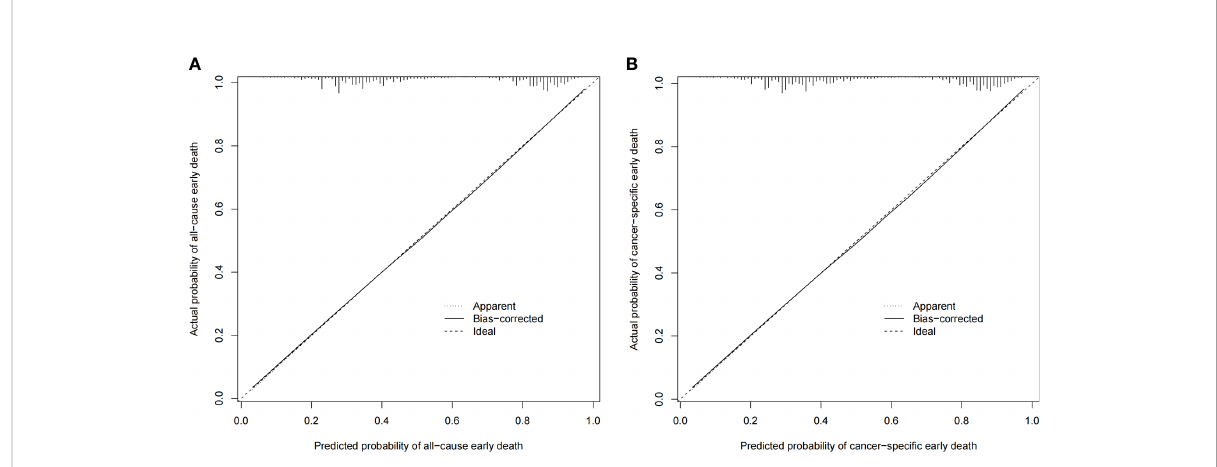
FIGURE 4 Calibration plots for the nomogram of (A) all-cause early death in the SEER database; (B) cancer-speci fi c early death in the SEER